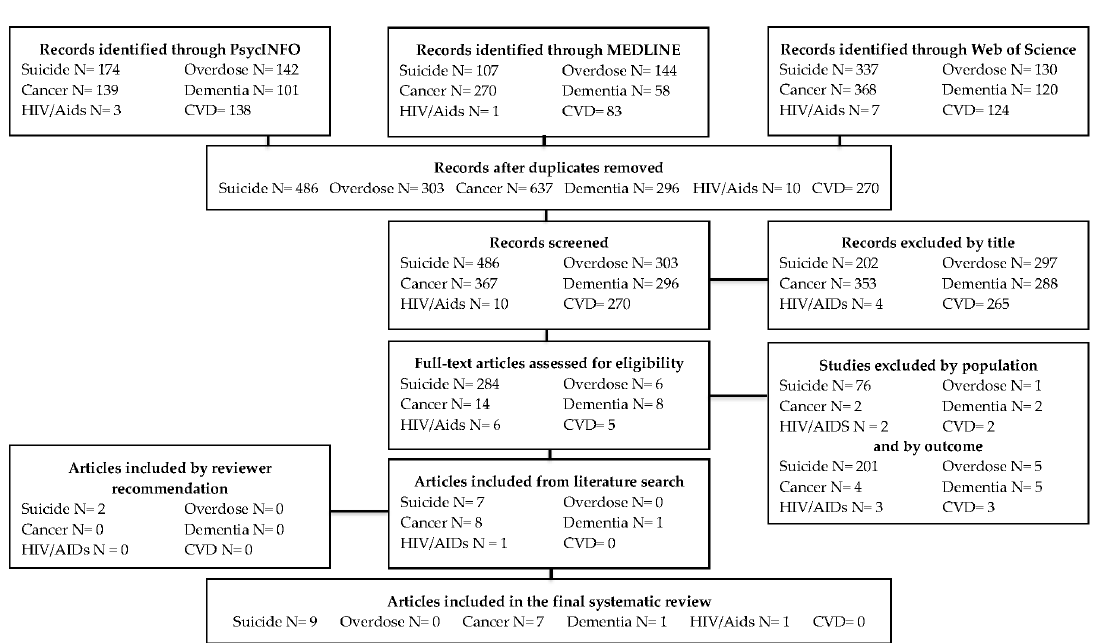
Figure 1. Flow diagram of search process guided by the PRISMA statement